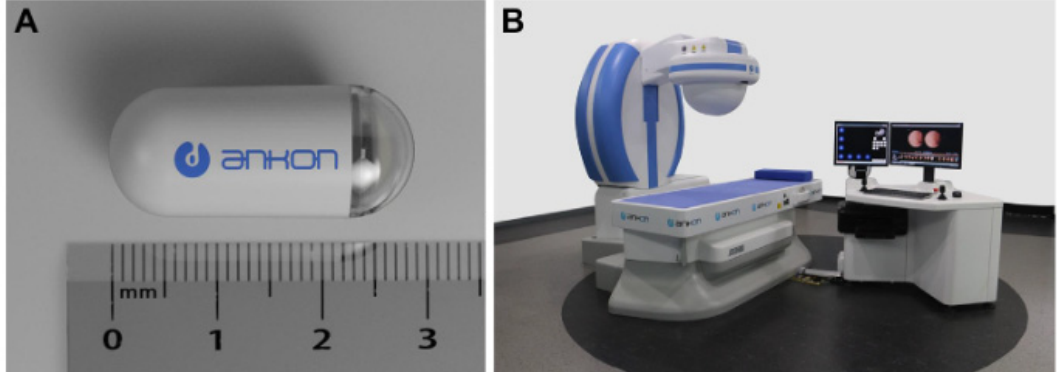
Figure 1. The magnetic-controlled capsule endoscopy system. ( A ) The NaviCam capsule endo-scope (Ankon Technologies Co, Ltd., Wuhan, China); ( B ) the NaviCam magnetic control system. Adapted from Liao et al. [17] with permission from Elsevier.